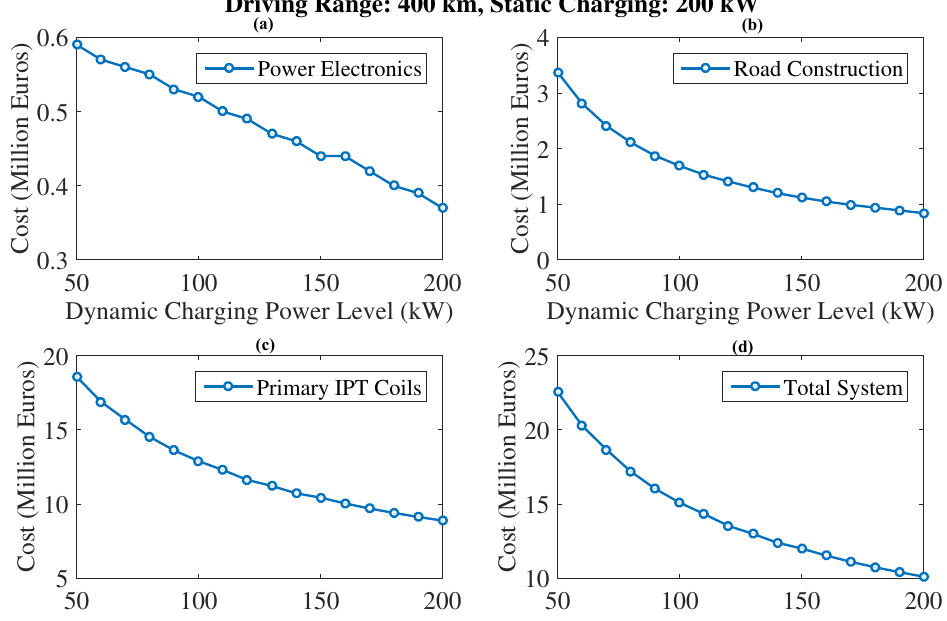
Figure 12. Cost estimation of the IPT charging system components ( a ) power electronics ( b ) road contruction; ( c ) primary IPT coils; and ( d ) total